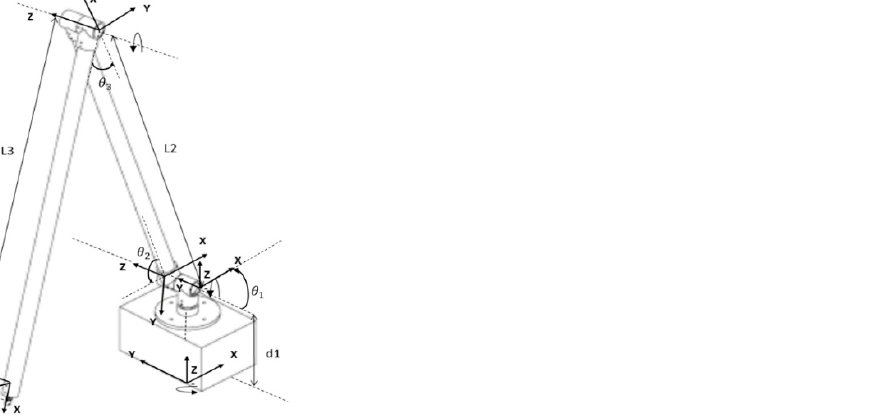
Figure 4. Diagram of the reference frame of the three-degrees-of-freedom anthropomorphic mechanism.